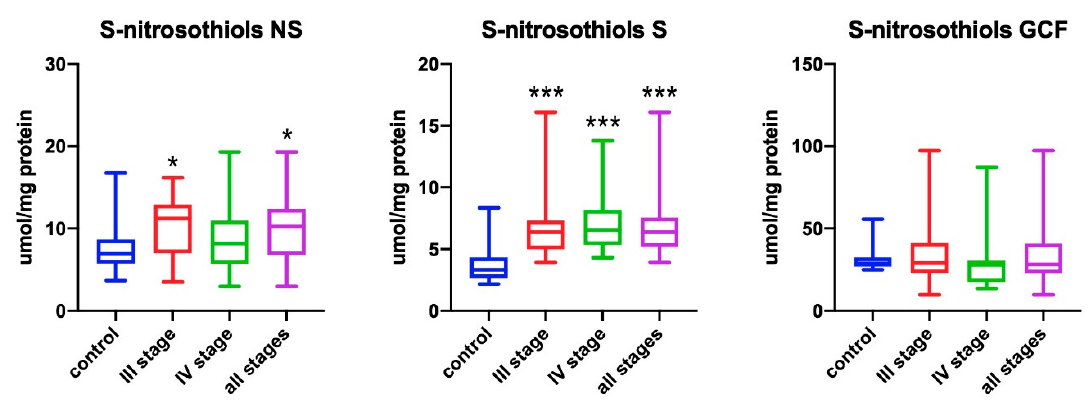
Figure 3. Concentrations of S -nitrosothiols in non-stimulated saliva (NS), stimulated saliva (S), and gingival crevicular fluid (GCF) in all patient groups. * p < 0.05, *** p < 0.001 versus control group.